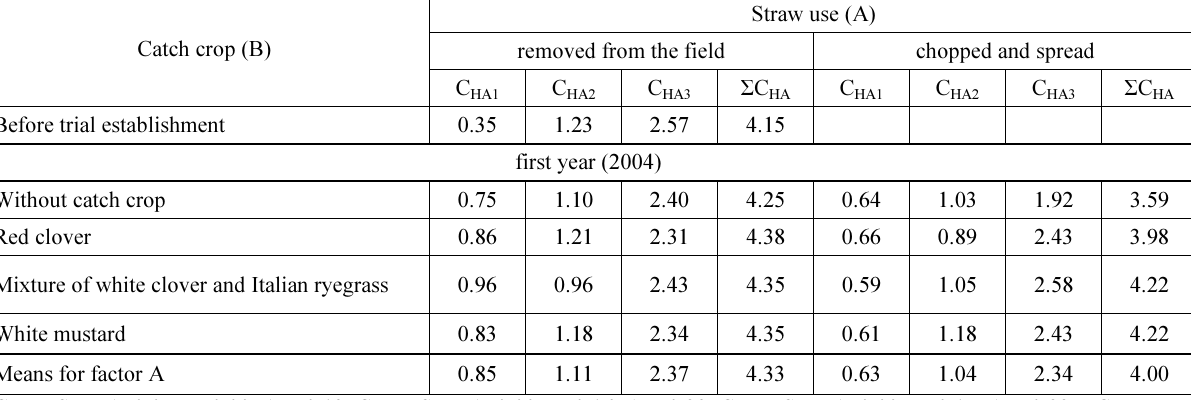
Straw use (A) removed from the field chopped and spread Catch crop (B)